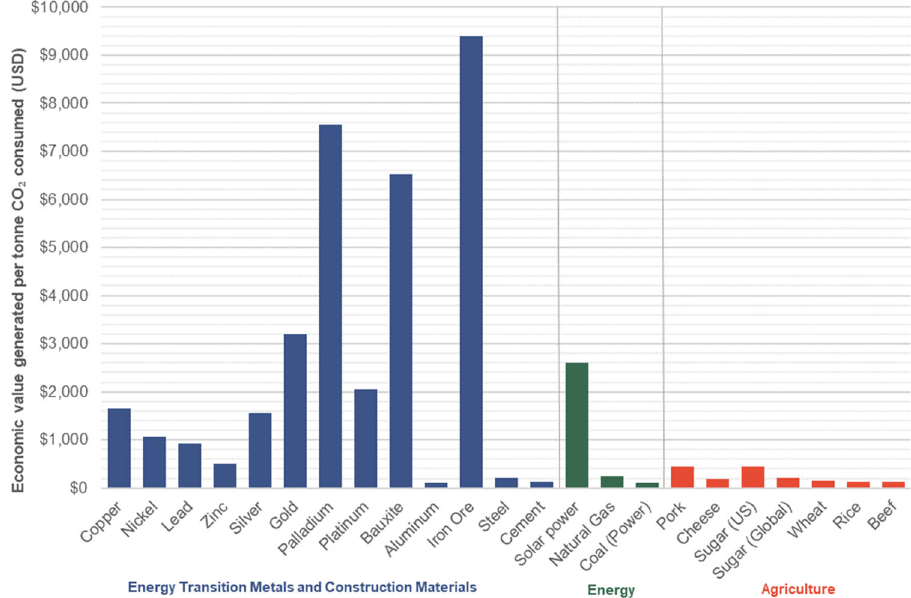
Fig. 2 Economic value of commodities per tonne of CO 2 . Economic value per tonne of CO 2 emitted in USD for selected energy transition metals and construction materials (blue), energy industry commodities (green), and selected agriculture products